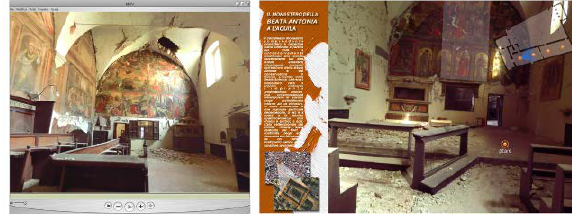
Figure 9. Browsing using spherical panoramas and screenshots of the web-based virtual tour created for the exploration of the areas and the consultation of additional metadata (software: Pano2VR,